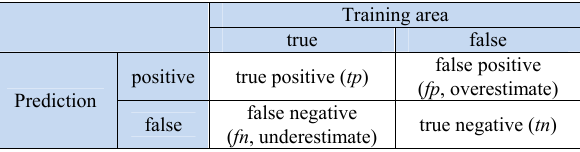
Lower limit of the average size in all objects ( Sc ) Minimum step size of weight parameters ( dt ) Target value of F-measure